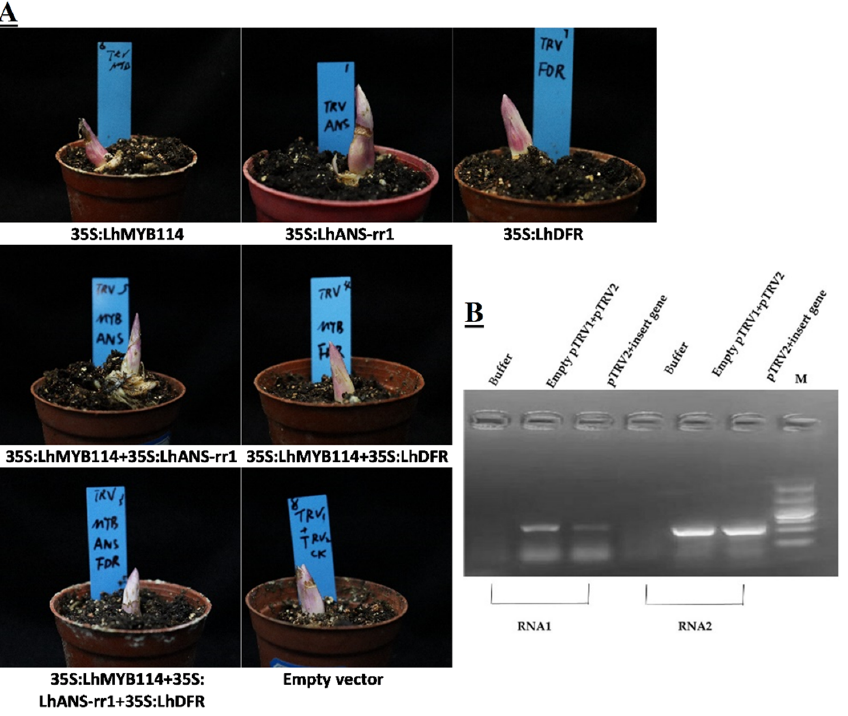
Figure 7. Transient silencing phenotypes among LhMYB114 , LhANS-rr1, and LhDFR in Lilium flower buds by virus-induced gene silencing (VIGS). ( A ) Photographs of Lilium flower buds from TRV- infected plants. ( B ) RT-PCR detection of RNA1 and RNA2 of TRV1 and TRV2 in Lilium .